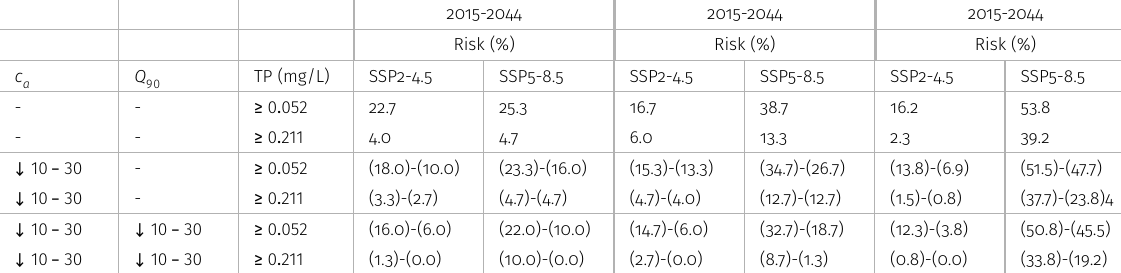
Table IV. Effects of reductions in the influent Phosphorus Total (TP) concentration and reservoir withdrawal on the risk of eutrophication for two emission scenarios and three future